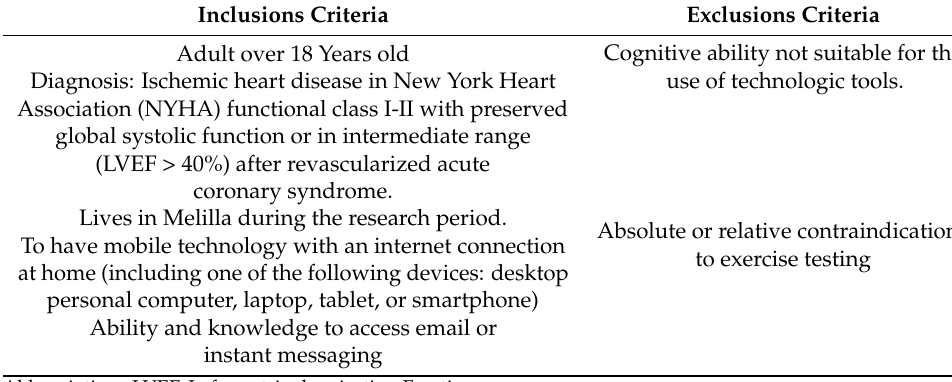
Table 1. Inclusion and exclusion criteria. Inclusions Criteria Adult over 18 Years old Cognitive ability not suitable for